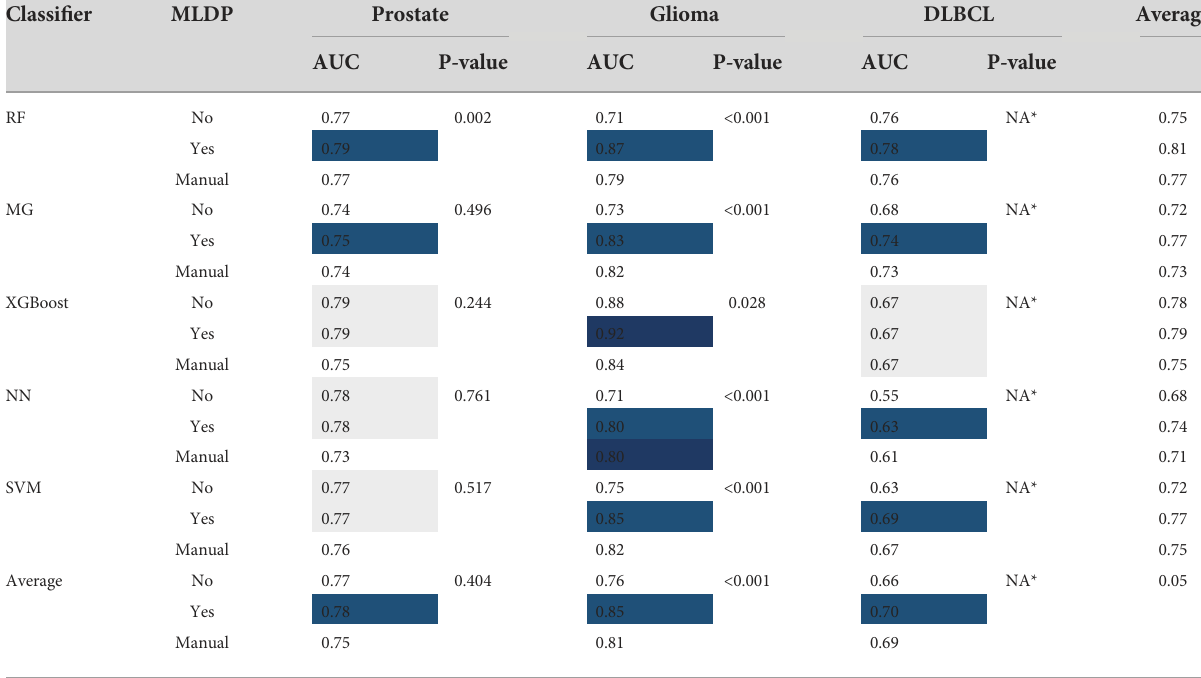
TABLE 4 The cross-validation area under the receiver operator characteristics curve (AUC) of all cohorts and machine learning (ML) methods with and without ML-driven data preparation (MLDP) as well as manually preprocessed across Monte (MC) cross-validation folds. Classi fi